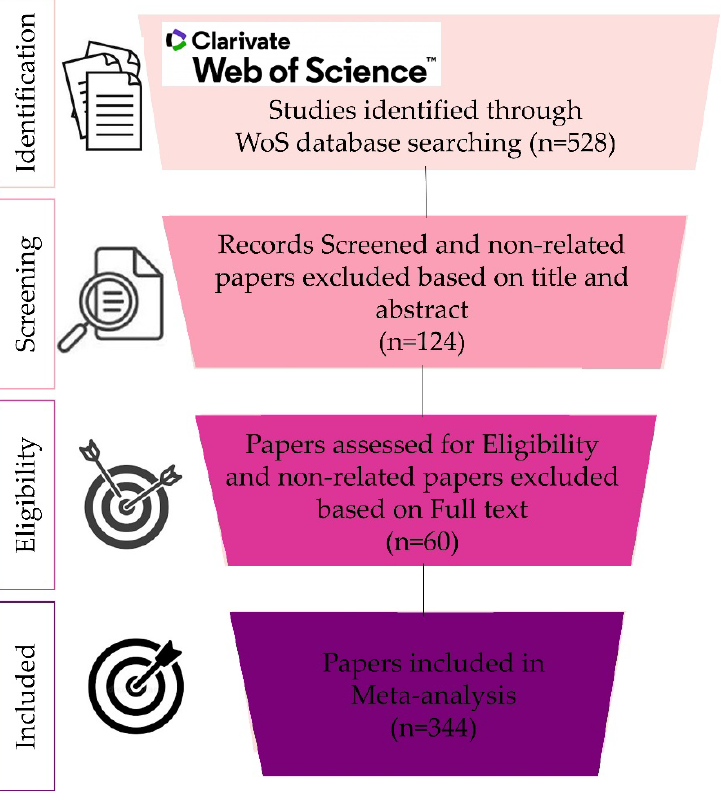
Figure 3. Paper selection and the review process flow diagram. A total of 528 papers were found in our primary search in the WoS database. A listing of extracted sub-fields/attributes considered for the content analysis of included